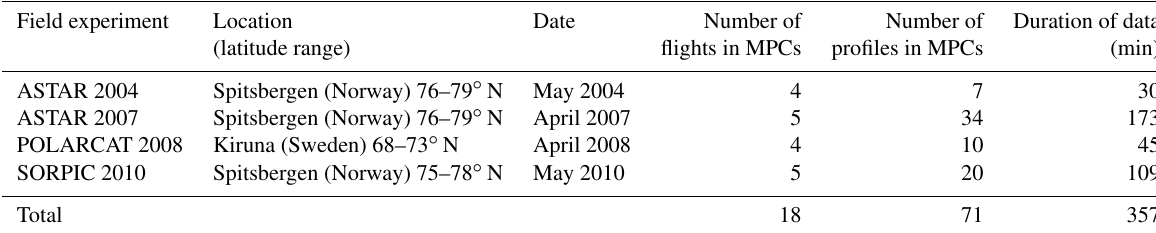
Table 1. Summary of in situ observations of Arctic single-layer MPCs. Field